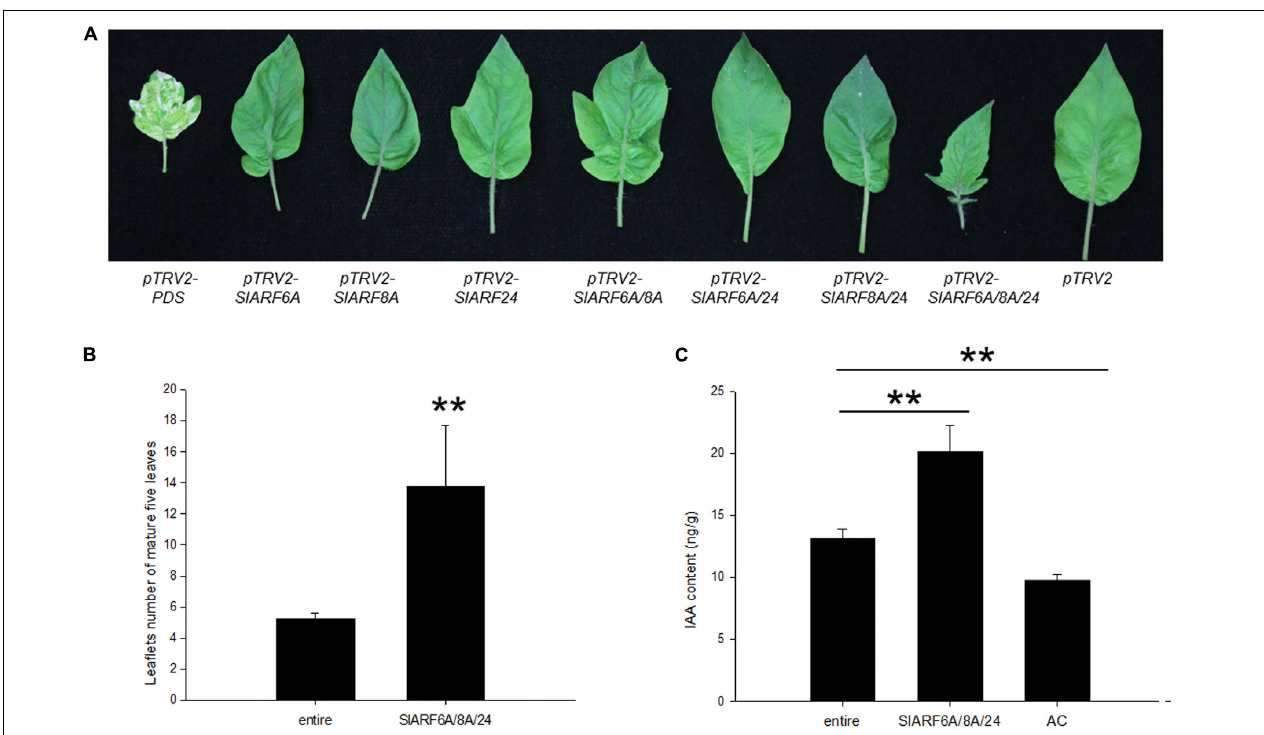
FIGURE 4 | Leaves phenotypes and the free IAA contents of silencing of candidate SlARF genes in tomato e mutation. (A) The mature fifth leaves of the indicated phenotypes. (B) Quantification of the total leaflets number of the mature first five leaves ( n = 5). (C) The IAA contents in e mutant and silencing of all the four SlARF genes materials. Standard errors (SE) are shown ( n = 3). ∗ P < 0.05, ∗∗ P <